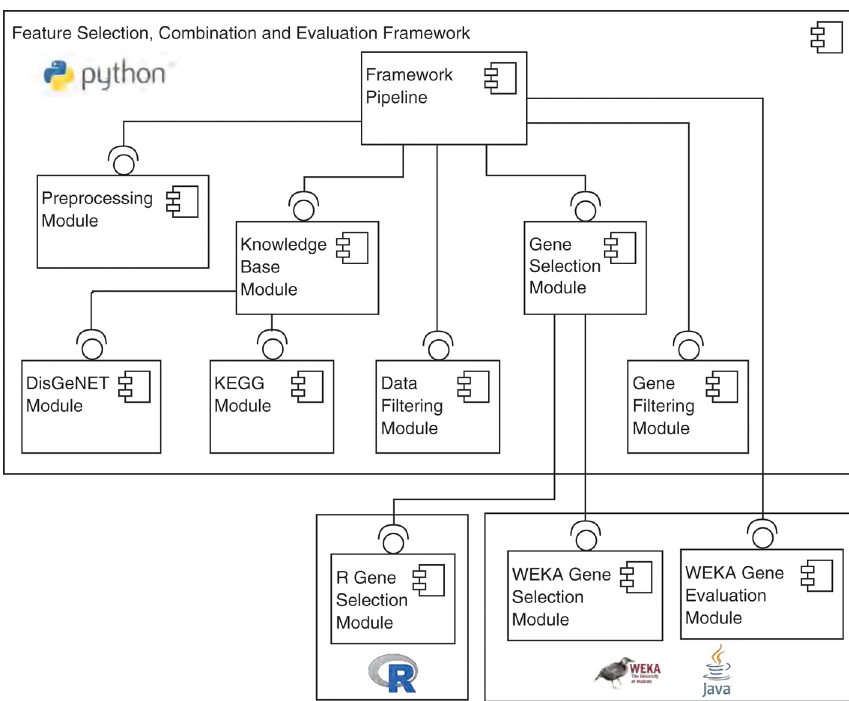
Figure 4: The architecture of the framework. Each processing step is encapsulated in an own module, with the Frame- work Pipeline module orchestrating the overall